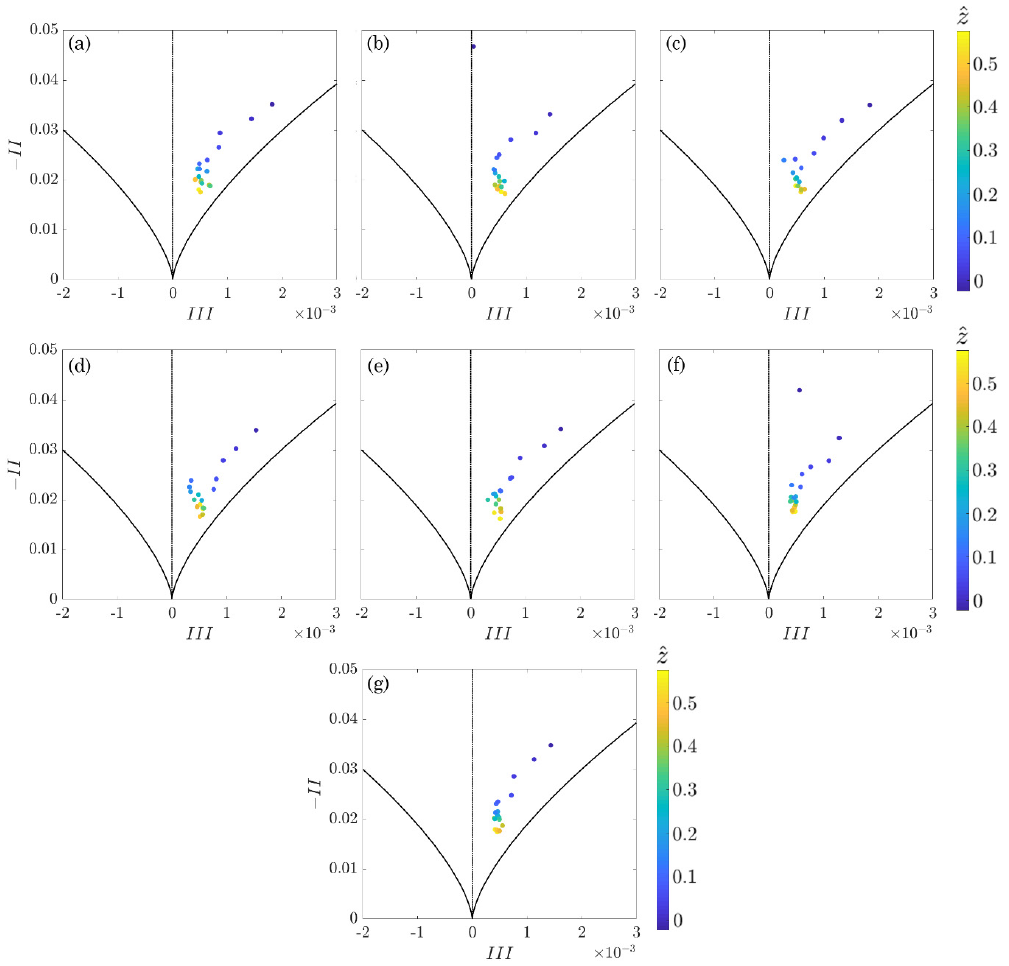
Figure 7. AIMs of Run 1 at ( a ) x / L s = 0, ( b ) x / L s = 0.17, ( c ) x / L s = 0.33, ( d ) x / L s = 0.50 (at the vegetation stem axis), ( e ) x / L s = 0.67, ( f ) x / L s = 0.83, ( g ) x / L s = 1.00.